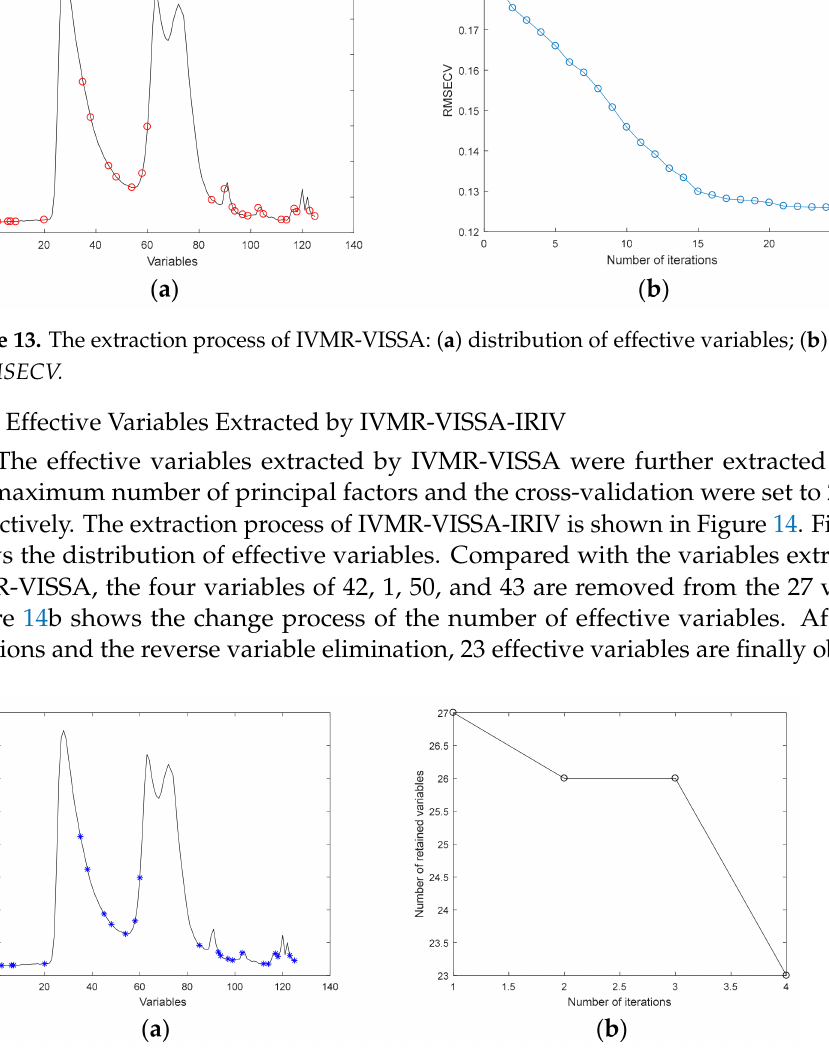
Figure 14. The extraction process of IVMR-VISSA-IRIV: ( a ) distribution of effective variables; ( b ) the change process of the number of effective variables.